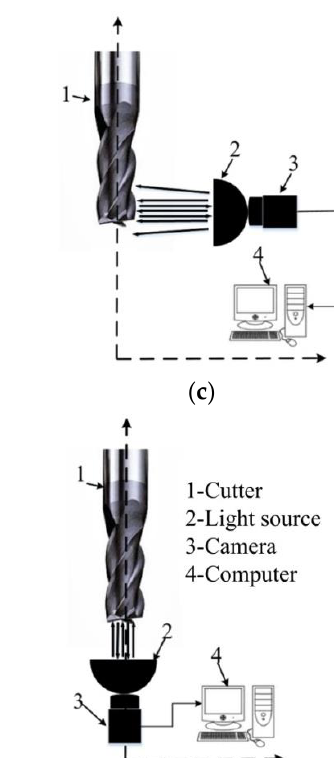
Figure 1. Photos of typical failure forms of integral spiral end milling cutter: ( a ) Crater wear; ( b ) Flank wear; ( c ) Edge chipping; ( d ) Tool tip breakage.